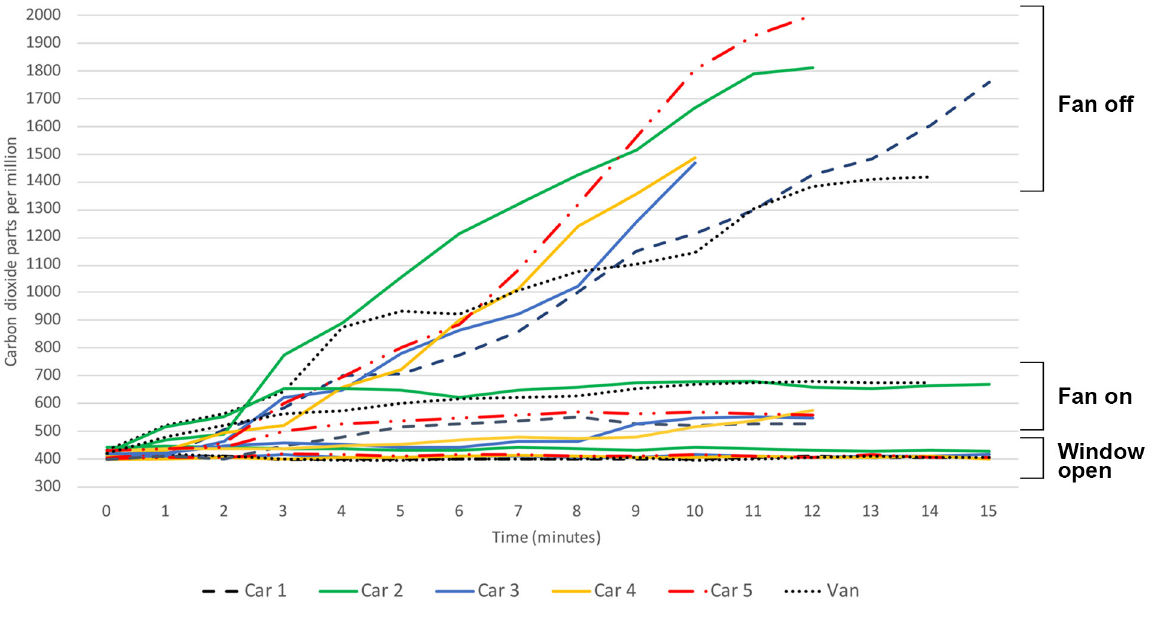
Figure 1. Parked Vehicles. Carbon dioxide levels in the parked motor vehicles under 3 different ventilation conditions. The 5 cars had 2 occupants and the van had 3 occupants. Ventilation conditions included 1 front window fully open with fan off, windows closed with fan on at medium speed, and windows closed with fan off. Carbon dioxide readings above 800 parts per million were considered an indicator of suboptimal ventilation.